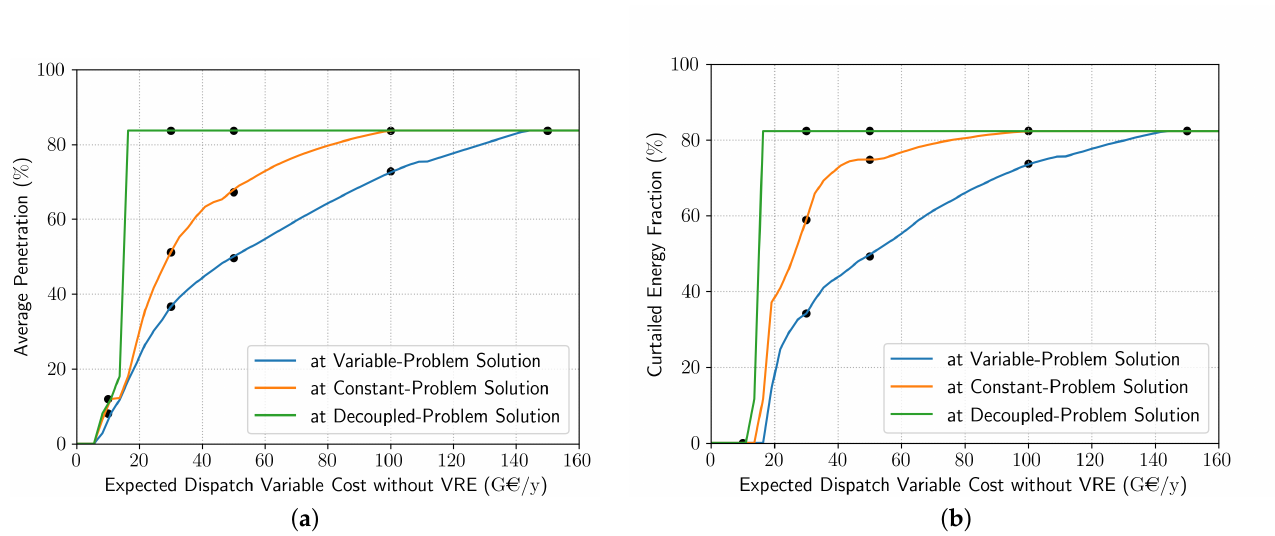
Figure 4. ( a ) Average penetration (Equation (26)) versus the expected system total cost without variable renewable energy, E ( STC ( 0 )) = T (cid:104) α L 2 (cid:105) , for numerical approximations of the optimal solutions to the variable problem (Equation (4)) 0 (blue), the constant problem (Equation (14)) (orange), and the decoupled problem (Equation (11)) (green). The black dots indicate—here and in the following plots—the values of these metrics for selected values of the expected system total cost without variable renewable energy, i.e., 10, 30, 50, 100 and 150G A C/y. ( b ) Corresponding fraction of energy